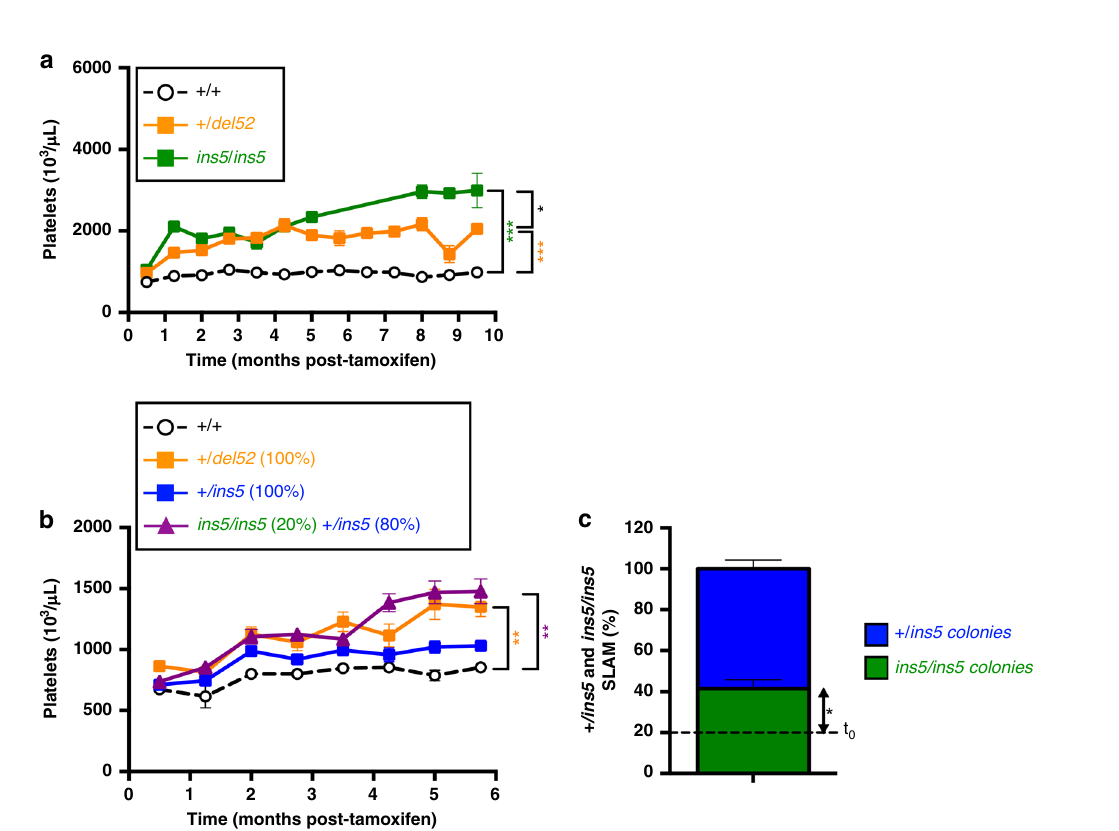
Fig. 7 Evolution of homozygous del52 and ins5 cells in blood and BM cells. Percentages of a del52/del52 (yellow, pink, red, brown and black squares and solid lines) and b ins5/ins5 (turquoise, blue, green, dark blue and black squares with solid lines) mutated KI cells in platelets (CD41 + ) and erythroid (Ter-119 + ) blood cells was determined as GFP − cells and in granulocytes (Cd11b + Gr-1 + ) as CD45.2 + GFP − cells, and are expressed as means ± SEM (in a : n = 4 for 0%, n = 4 GFP − CD41 + , n = 4, 4, 4, 2, 4, 4 CD45.2 + GFP − Cd11b + Gr-1 + , n = 4, 4, 4, 3 GFP − Ter-119 + for 10%, n = 5 for 25 and 50%, n = 4, 4, 4, 4, 3, 4 GFP − CD41 + and n = 4 for 75%, n = 5 and 2 for the last point for 100%; in b : n = 3 for 0%, n = 4 for 10%, n = 4 and 3 for the last point for 25%, n = 5 for 50%, 75%, and 100%, with n being individual mice and varying depending on time of sampling during the course of the experiment and on the group de fi ned as the percentage of engrafted homozygous cells, as indicated in the Source data fi le). Signi fi cance to the 100% condition (black squares with connecting black solid line) was measured with nonparametric Kruskal – Wallis ’ s multiple comparison test. In a , * p = 0.0167 (10%, GFP − CD41 + ), 0.0334 (25%, CD45.2 + GFP − Cd11b + Gr-1 + ); ** p = 0.0023 (10%, CD45.2 + GFP − Cd11b + Gr-1 + ), 0.0094 (10%, GFP − Ter-119 + ) and in b , * p = 0.0106 (25%, GFP − CD41 + ); ** p = 0.0011 (10%, GFP − CD41 + ), 0.0098 (25%, CD45.2 + GFP − Cd11b + Gr-1 + ), 0.0015 (10%, CD45.2 + GFP − Cd11b + Gr-1 + ), 0.0081 (10%, GFP − Ter-119 + ). c Percentages of homozygous del52 and ins5 cells (CD45.2 + GFP − cells) were assessed in HSC-enriched BM LSK and SLAM cells and are shown as means ± SEM, signi fi cance to the 100% condition with a two-sided parametric t -test: * p = 0.0344 (25% del52/del52 , LSK), 0.0152 ( del52/del52 SLAM), 0.0132 (10%, ins5/ins5 SLAM); ** p = 0.0143 (25%, ins5/ins5 LSK), 0.0028 (10%, ins5/ins5 LSK). d The percentages of BM SLAM 4 months after tamoxifen induction of KI expression were determined and expressed according to the percentages of initially engrafted homozygous del52 (colored squares and red solid line) and homozygous ins5 (colored circles and green solid line) BM cells. For c , d , n = 1 – 5 independent mouse BM were analyzed, depending on the percentage of engrafted homozygous cells, as indicated in the Source data fi le. Source data are provided as a Source data fi le.